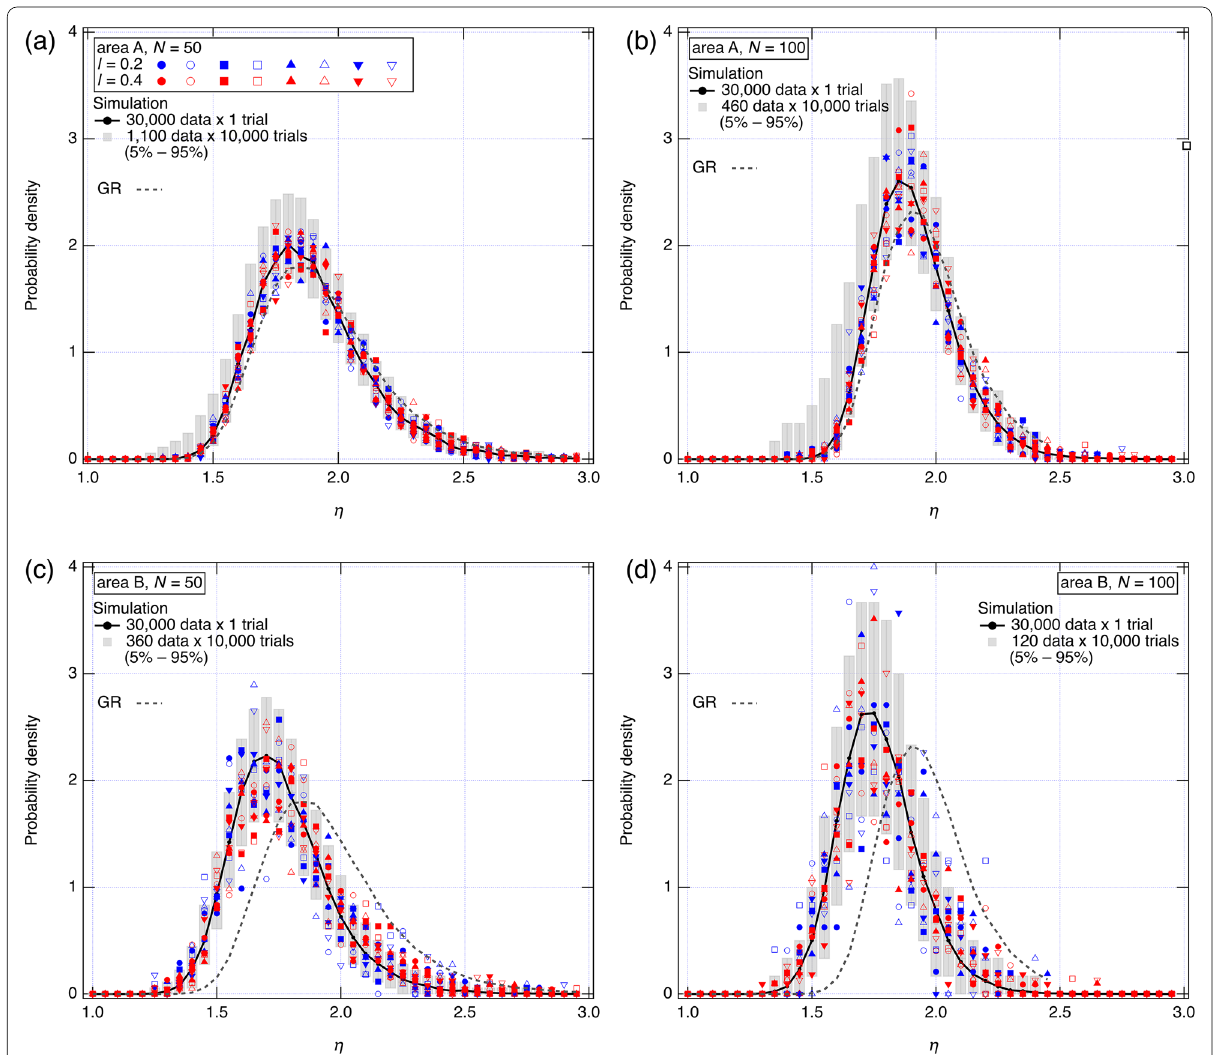
50 in area A; b N =